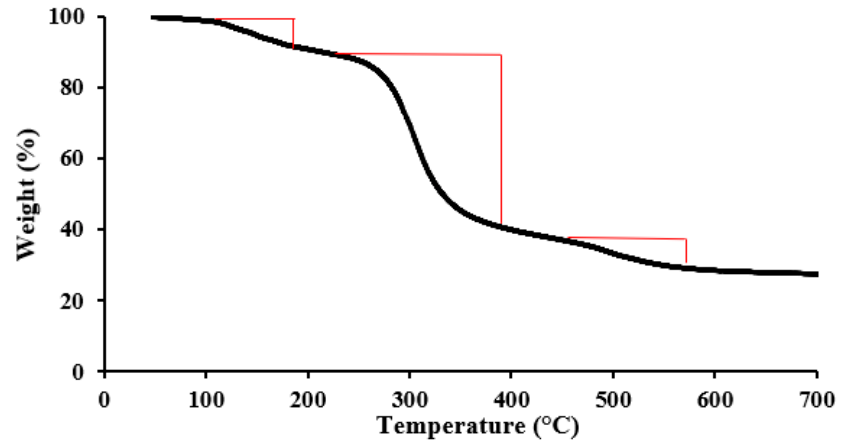
Figure 3. TGA curve of [MTMSPI][TS] ionic liquid.